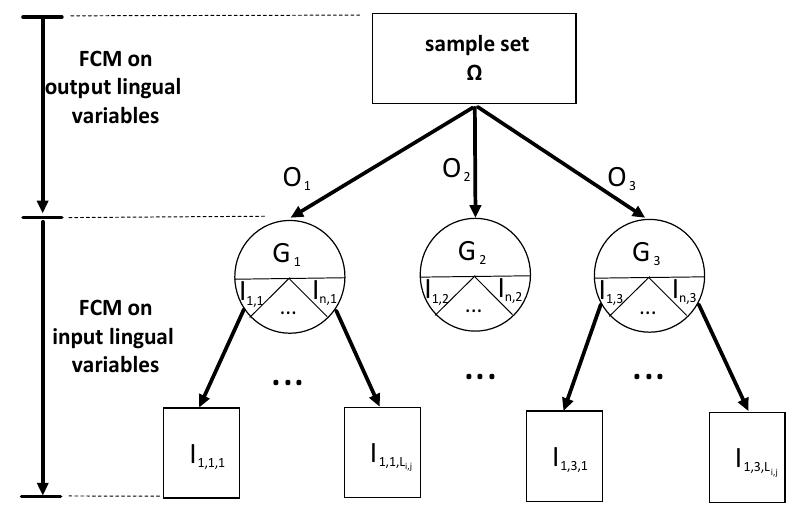
Figure 4. Classification process of the sample set.